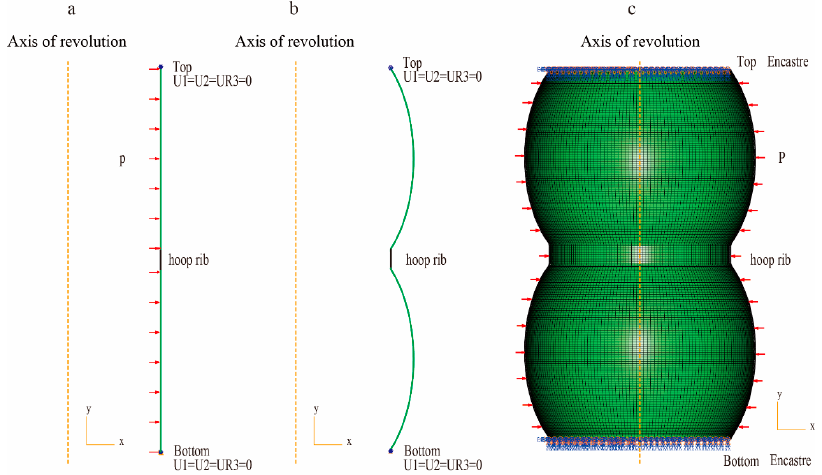
(Figure 11): (1) free bulging, (2) springback, and (3) external pressurisation. The thickness- to-diameter ratio of the bi-segment cylindrical preform was only 0.0093, as evaluated by the ABAQUS/Standard nonlinear static solver that was executed in the first and second steps of the simulation.